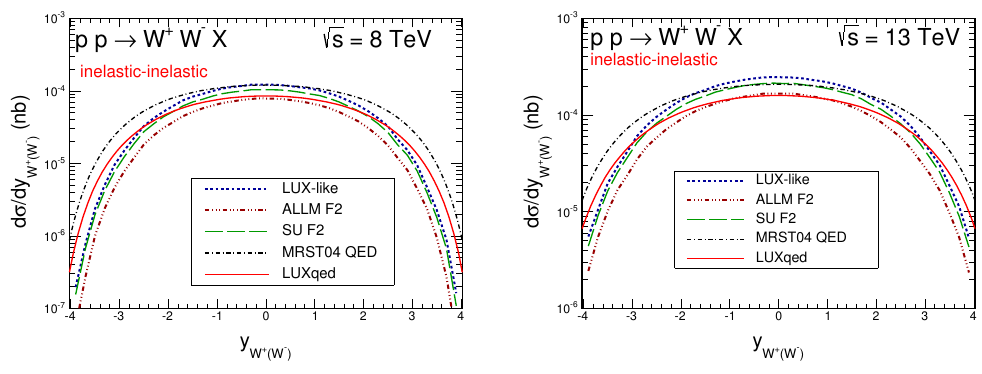
Figure 4 . Rapidity distribution of W + or W (cid:0) bosons for di(cid:11)erent structure functions: LUX-like, ALLM97, SU. The left panel shows results for the p for s = 13 TeV.